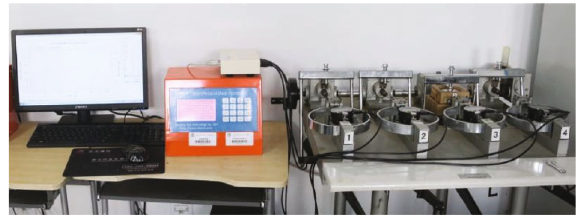
Figure 10: Strain control-type direct shear